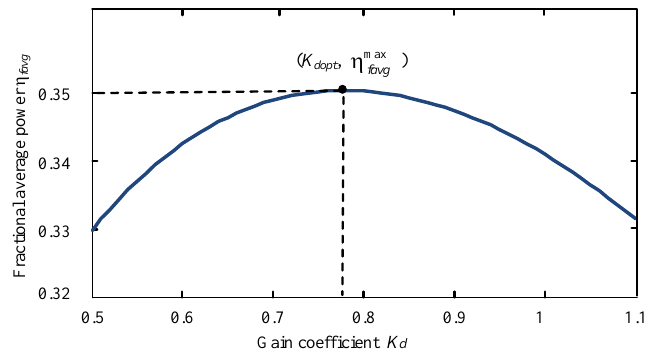
Figure 4. Optimal torque gain curve.